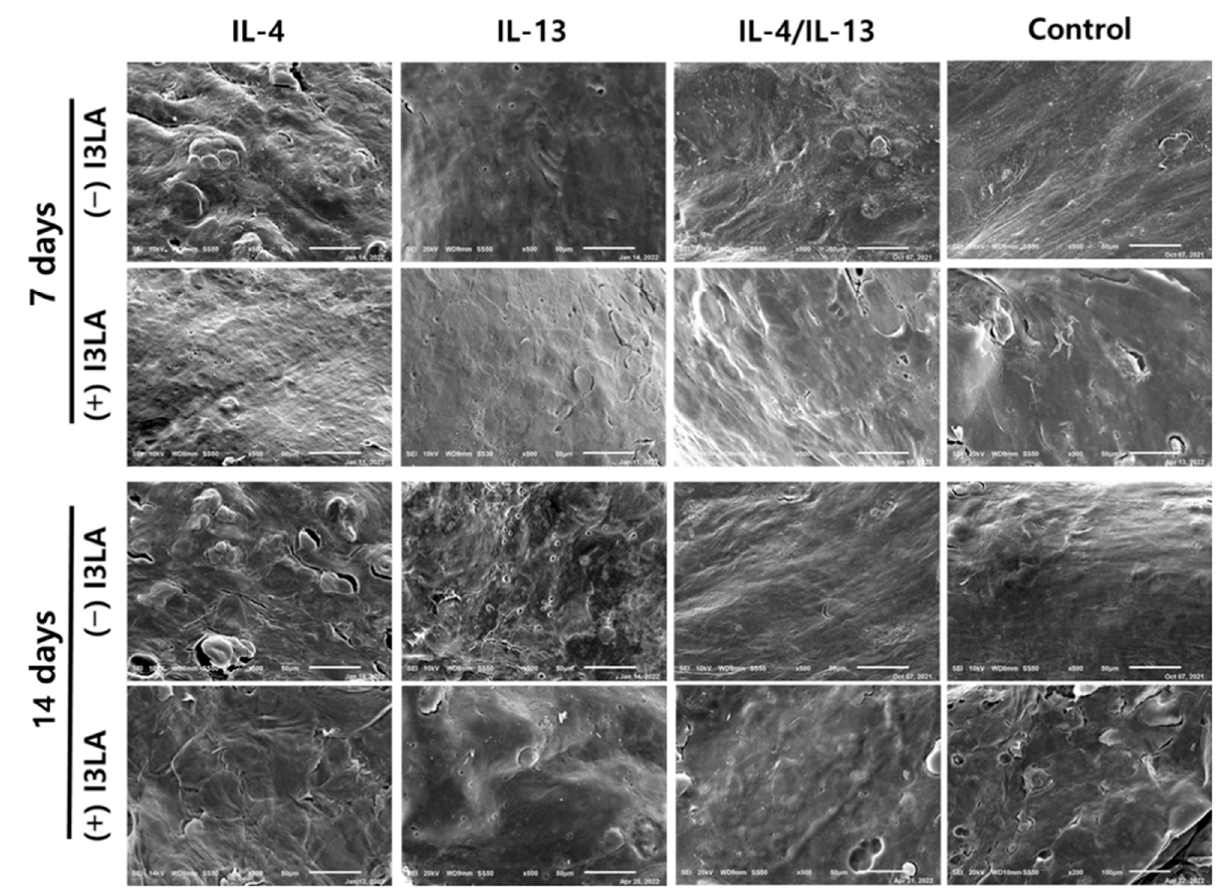
Figure 5. AD-HSEs were cultured under different conditions, and the surface was photographed using scanning electron microscopy (SEM). SEM results were taken from air-exposed epidermal surface views. Scale bar represents 50 μ m.